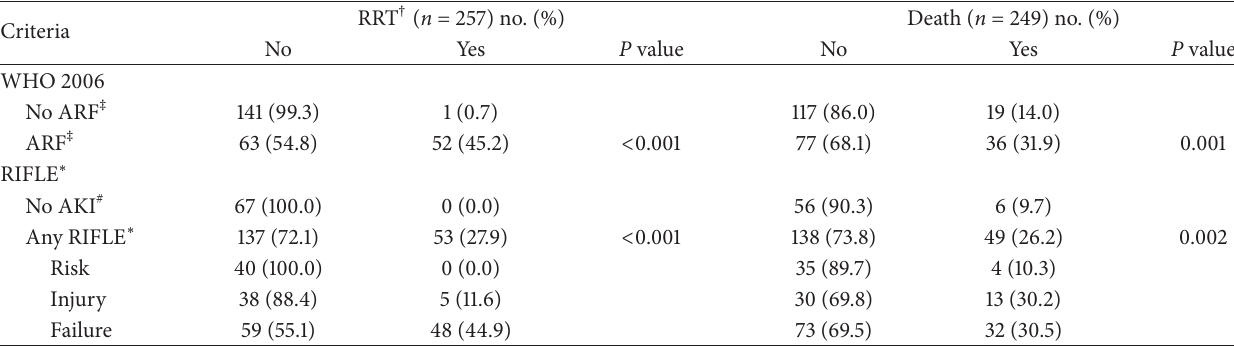
Table 2: Severe falciparum malaria patients with acute renal failure using the WHO 2006 and RIFLE ∗ criteria in relation to RRT † requirement and in-hospital mortality.